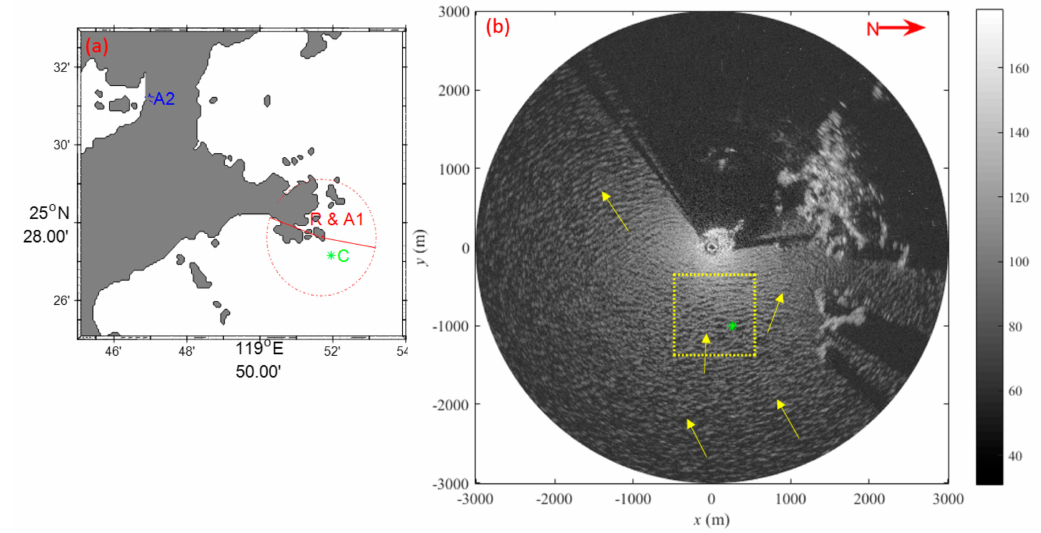
Figure 2. ( a ) Map of the experimental area, where R, C, A1 and A2 mark the locations of the radar station, current meter, and two anemometers, respectively. ( b ) A gray level X-band marine radar image acquired at 12:00 a.m. on 29 October 2014. The yellow bin signifies the study area, the green asterisk marks the location of current meter, the red arrow in the upper right points to north (with 0 ◦ pointing to the north), and the yellow arrows point the wave directions in several positions.